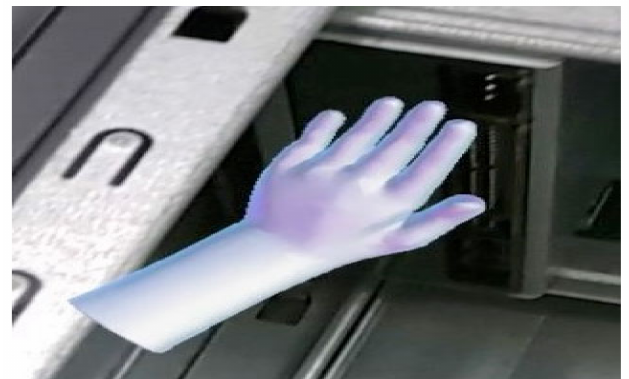
Figure 10. A virtual hand shows that a push on the DVD drive is needed to remove it from com- puter case.